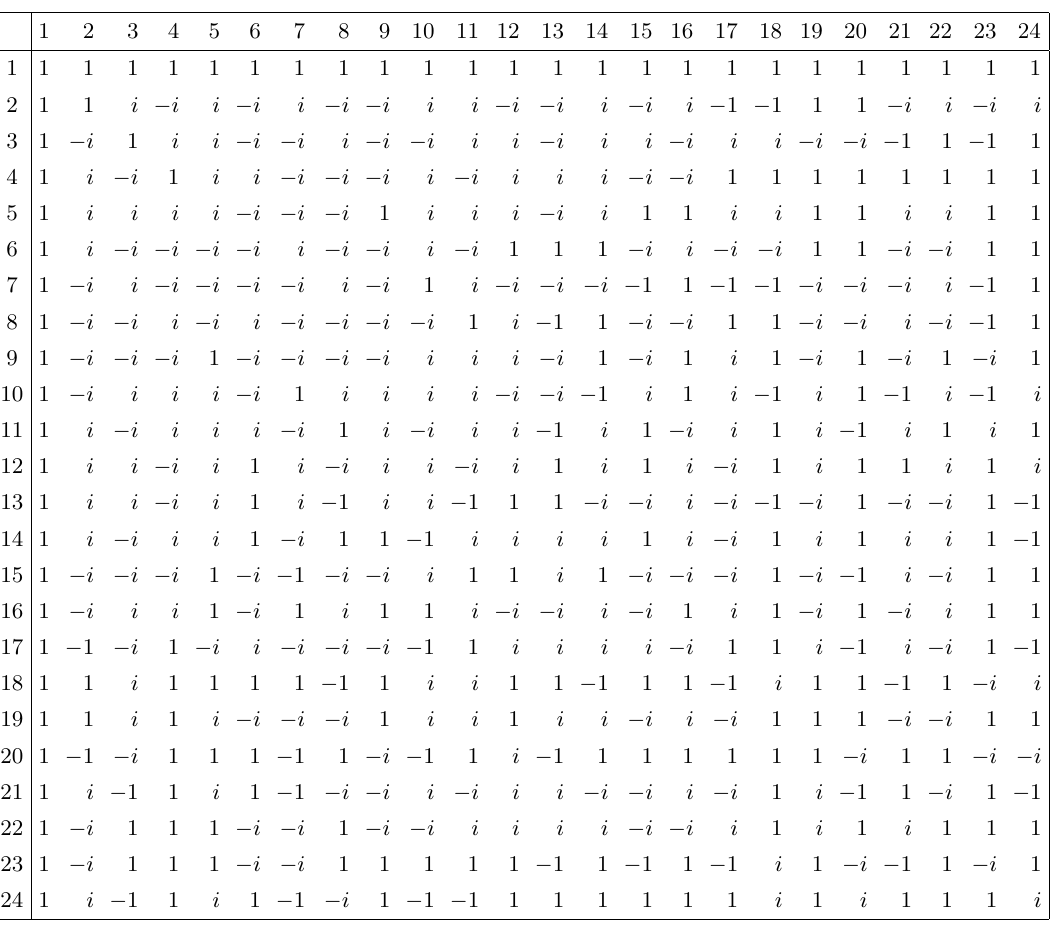
Table 11 . Cocycle for nontrivial element of H 2 ( S 4 , U(1)) . The transpositions are numbered, as given in table 13.